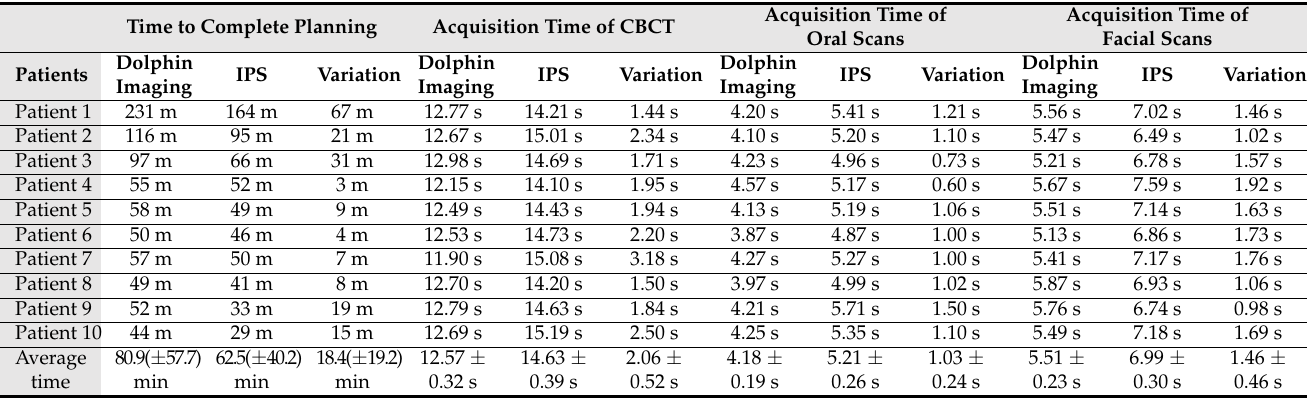
Table 1. Software comparison data: planning time, acquisition time for CBCT, intraoral scan, fa- cial scan.